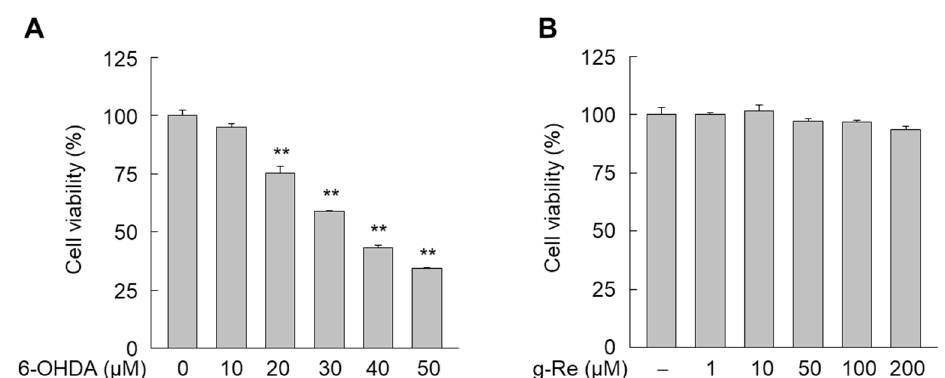
Figure 2. Effect of 6-Hydroxydopamine (6-OHDA) and ginsenoside Re (g-Re) on the viability of SH-SY5Y cells. Cells were treated with various concentrations of 6-OHDA or g-Re for 24 h, and cell viability was determined by the 3-(4,5-dimethylthiazol-2-yl)-2,5-diphenyltetrazolium bromide (MTT) assay. ** p < 0.01 compared to untreated group.